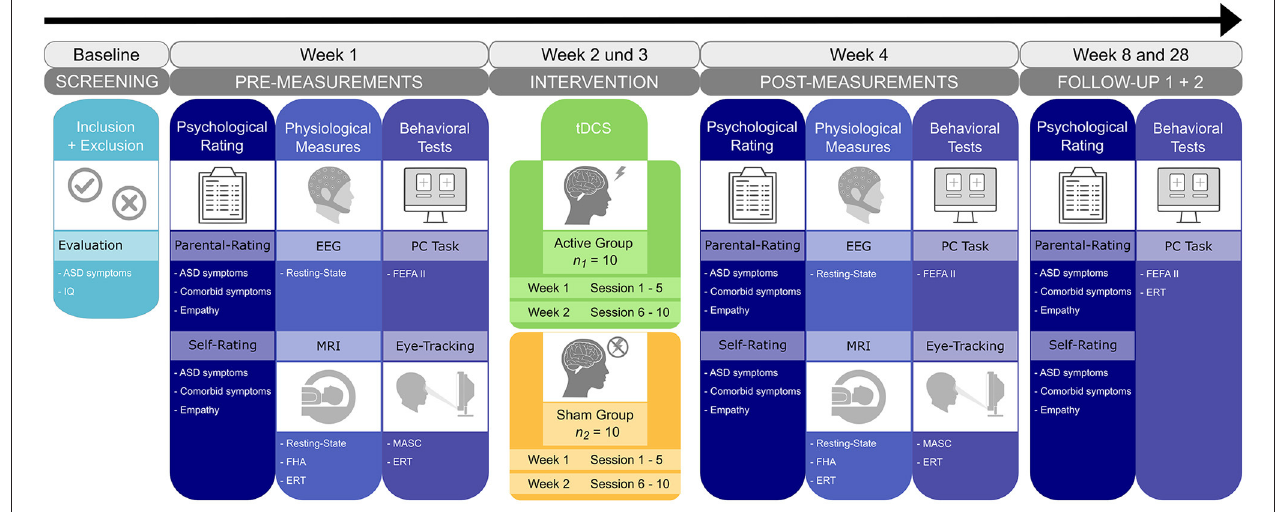
FIGURE 1 | Study timeline and overview. After enrollment, participants will undergo a set of psychological, behavioral, and physiological baseline measures in the first week. Following randomization, 10 sessions of either active or sham tDCS will be conducted within a 2-week interval. Post-treatment measures are repeated on the subsequent week. Two follow-up measures are planned 1 and 6 months after the end of the tDCS intervention. ERT, emotion recognition task; FEFA II, frankfurter test and training for recognizing facial affect; FHA, frith-happé animations; MASC, movie for the assessment of social